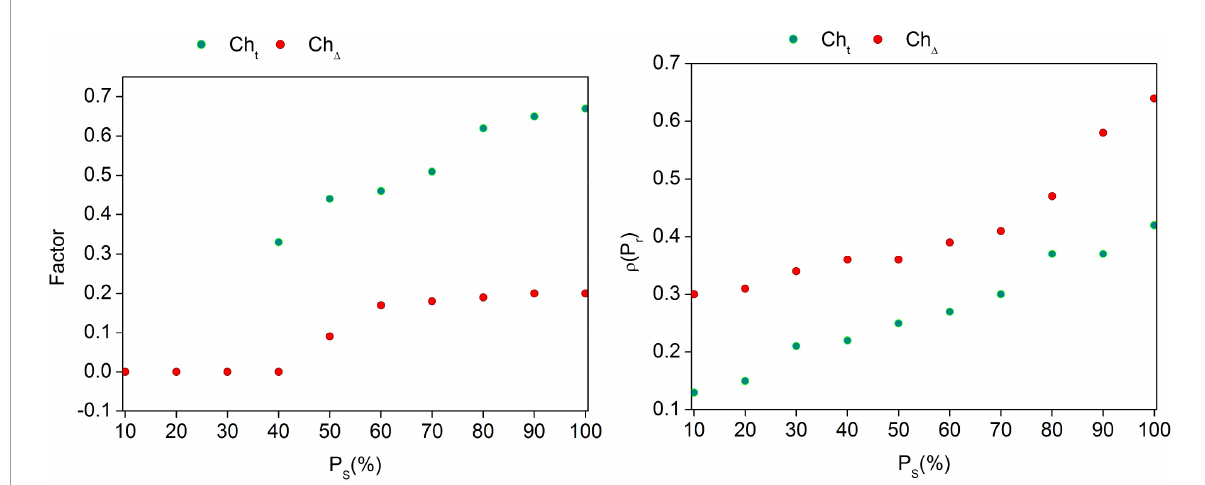
FIGURE4 PCh t , Ch (cid:49) , and ρ ( p r ) for the varying P S